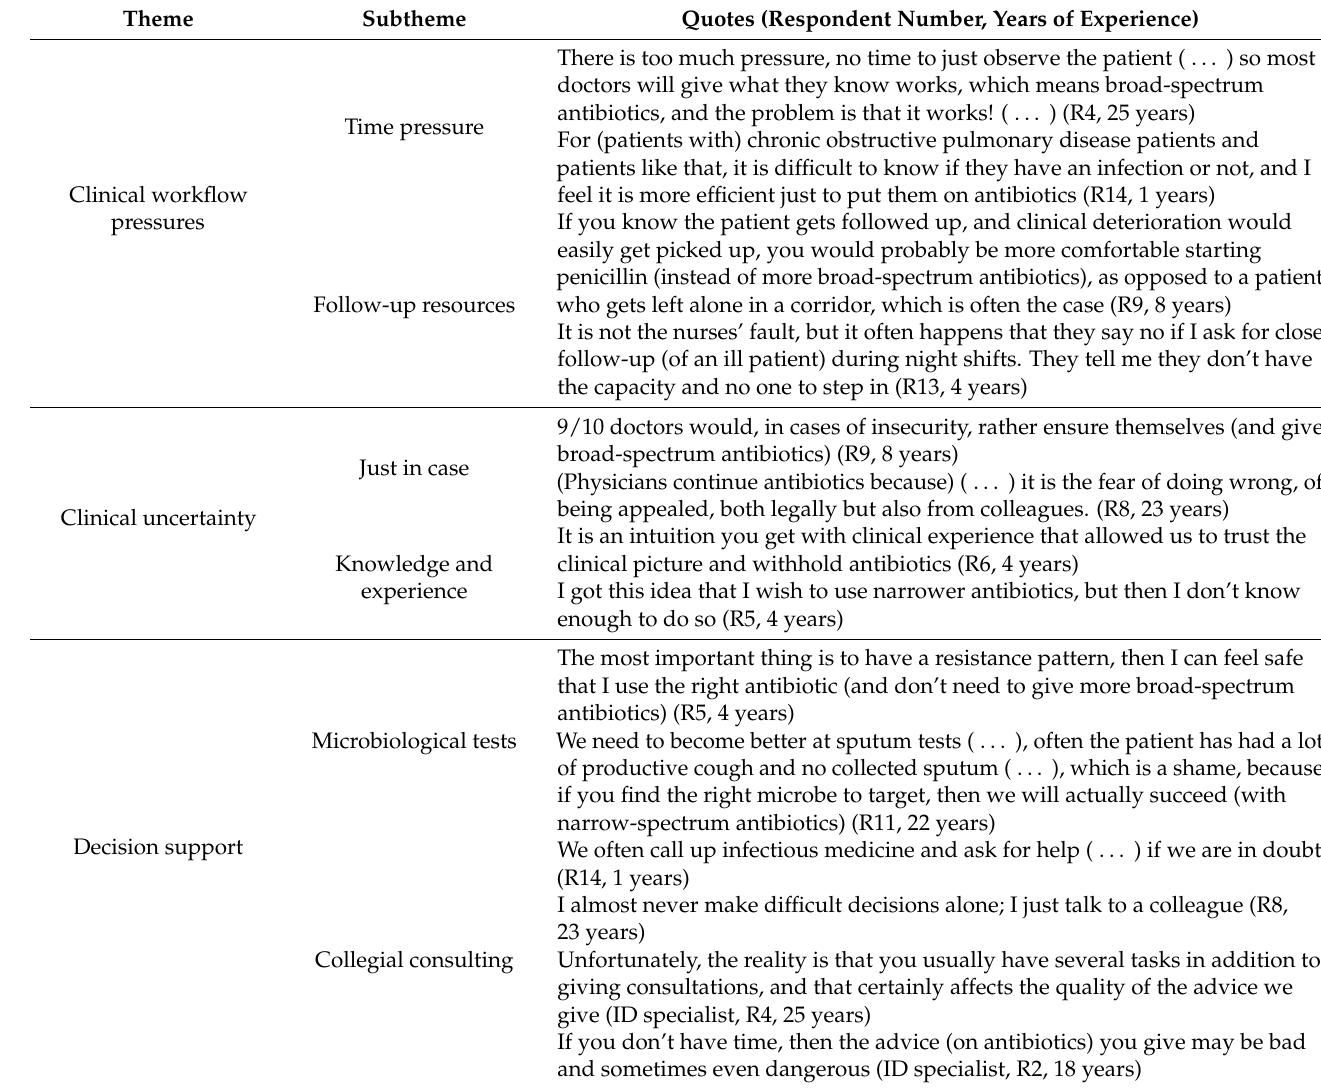
Figure 1. Visualization of the main themes (in the circle) with the consisting subthemes (squares). Table 2. Themes, subthemes, and illustrative quotes representing the determinants of antibiotic pre- scription.